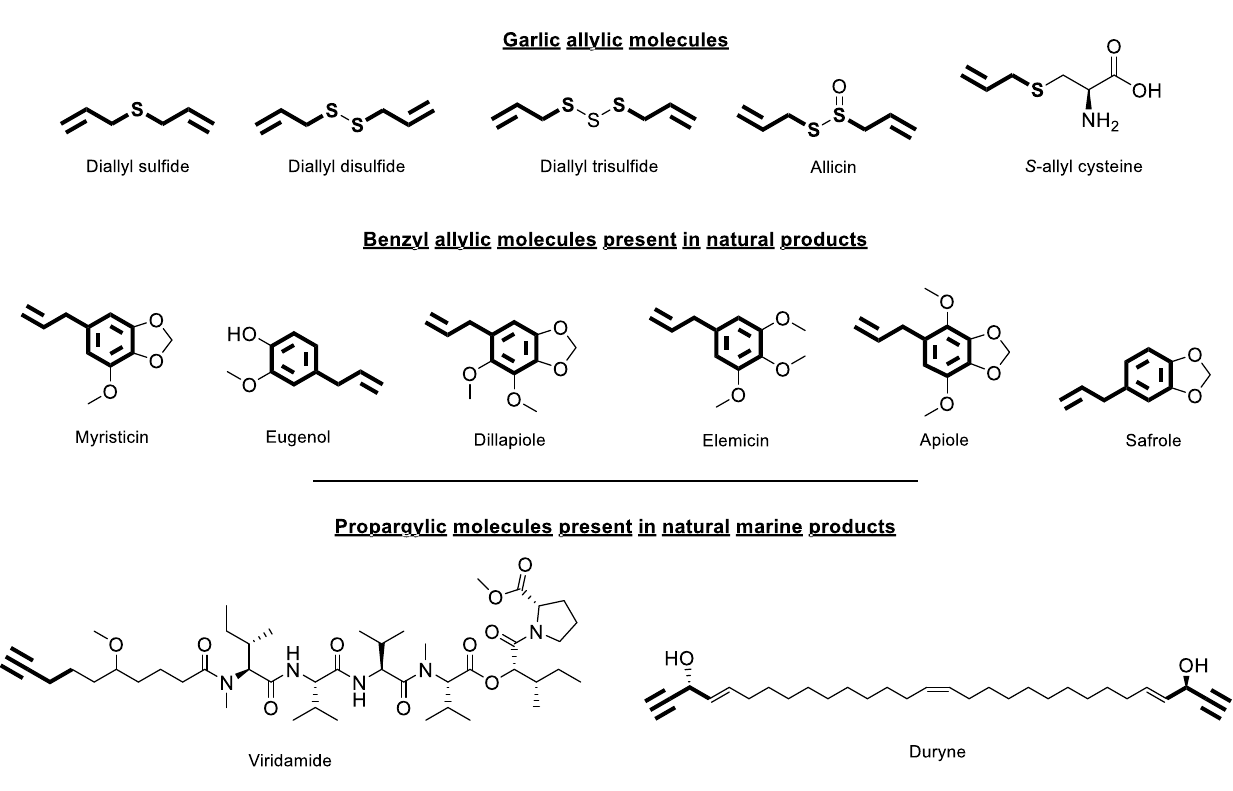
Figure 1. Allylic and propargylic molecules from natural products.